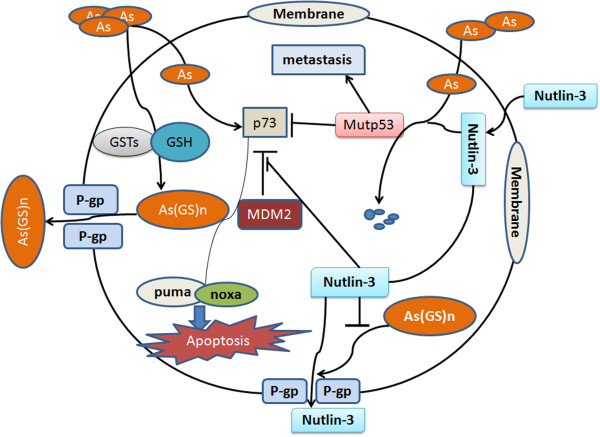
A schematic presentation for the possible mechanisms of arsenic trioxide resistance in HCC and the synergistical anticancer mechanisms of arsenic trioxide/Nutlin-3 combination in the current study.